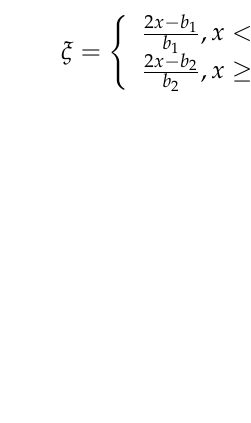
Figure 8. Schematic view of the crack problem in two bonded half